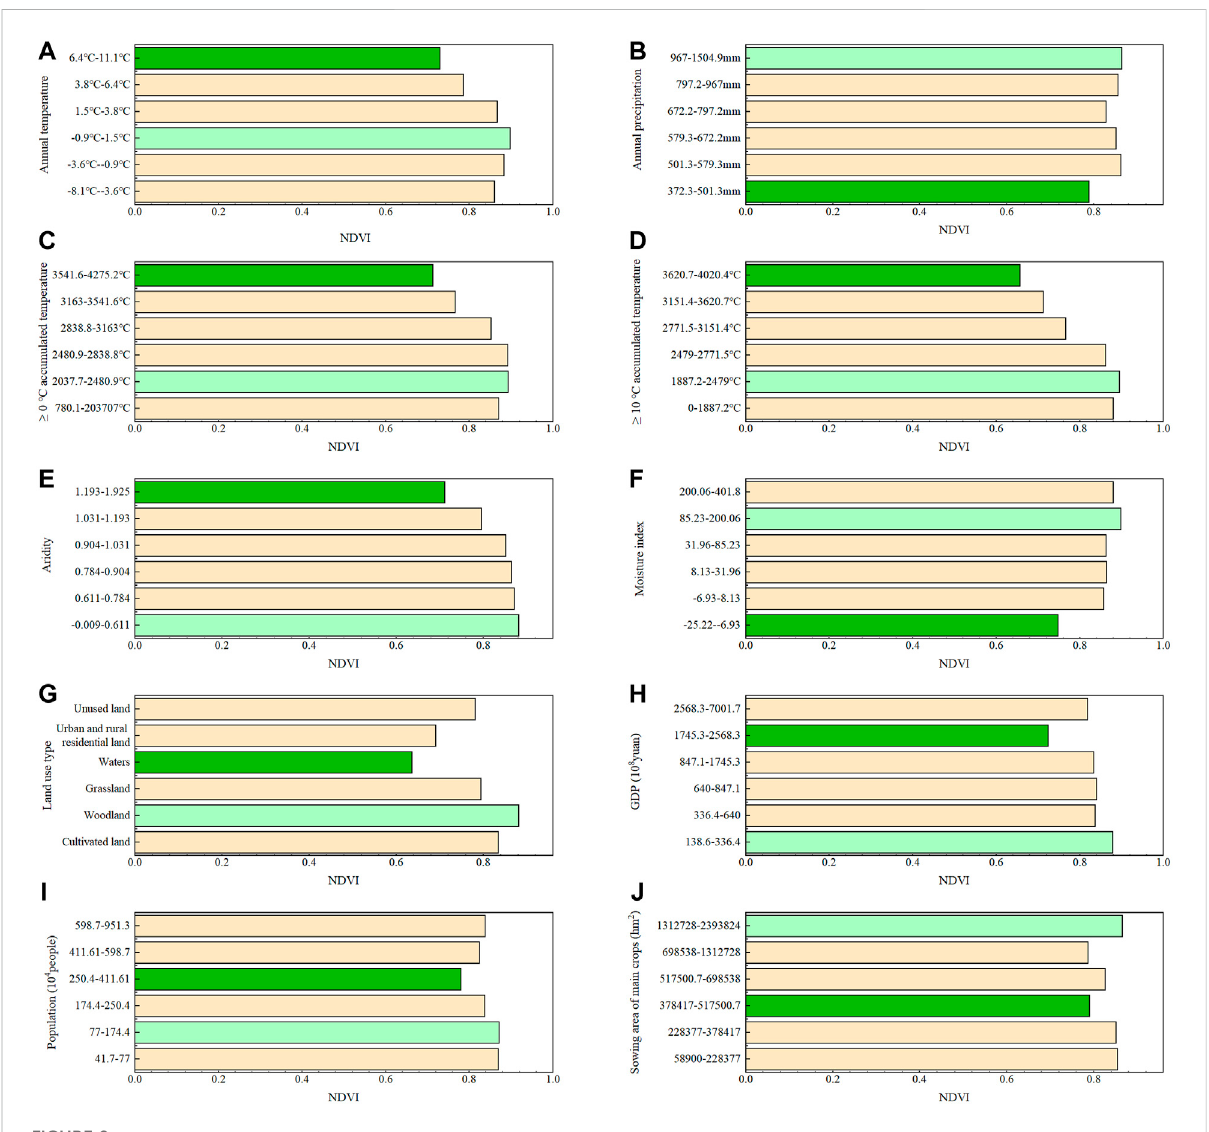
FIGURE 9 Suitable range of each factor index in the three northeast provinces (A – J)